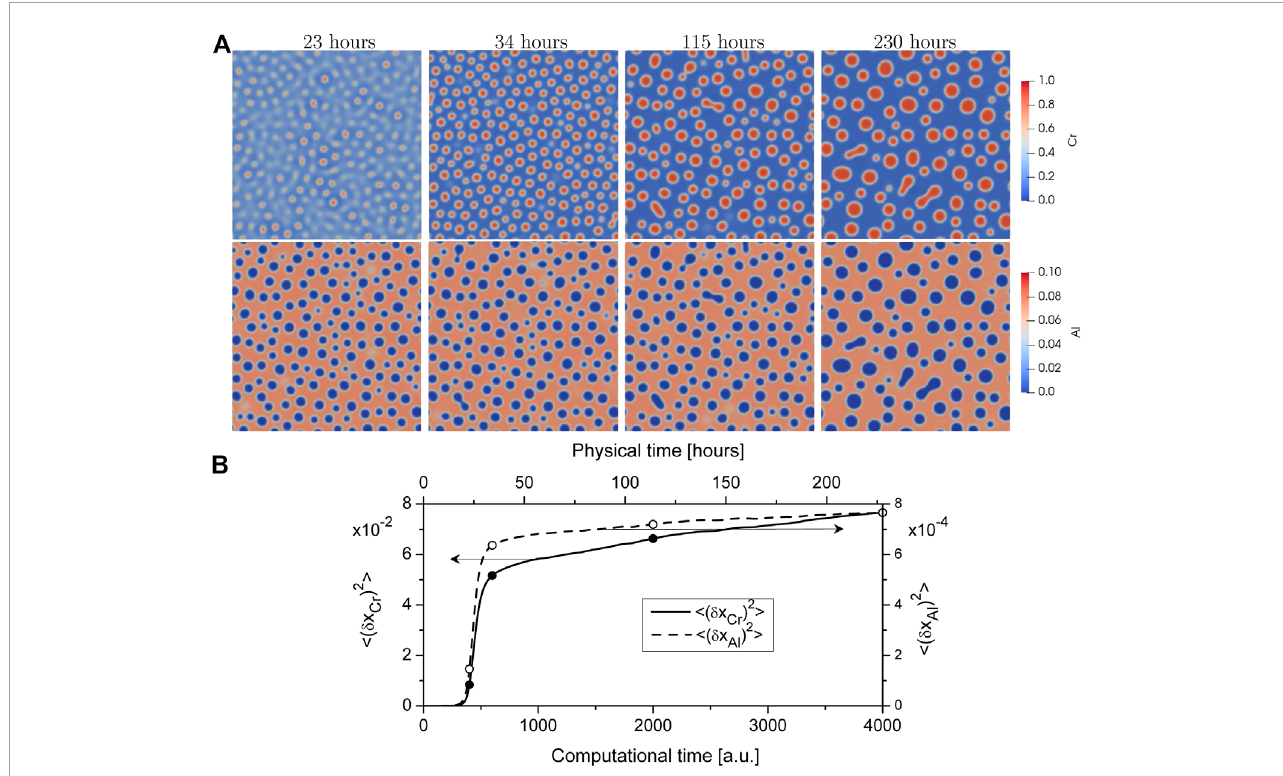
FIGURE 2 (color online) Snapshots of the microstructure evolution (A) and dynamics of the order parameters ⟨( δ x Cr ) 2 ⟩ and ⟨( δ x Al ) 2 ⟩ (B) during thermal treatment of the solid solution Fe − 30 %Cr − 5 %Al at T = 710 K .